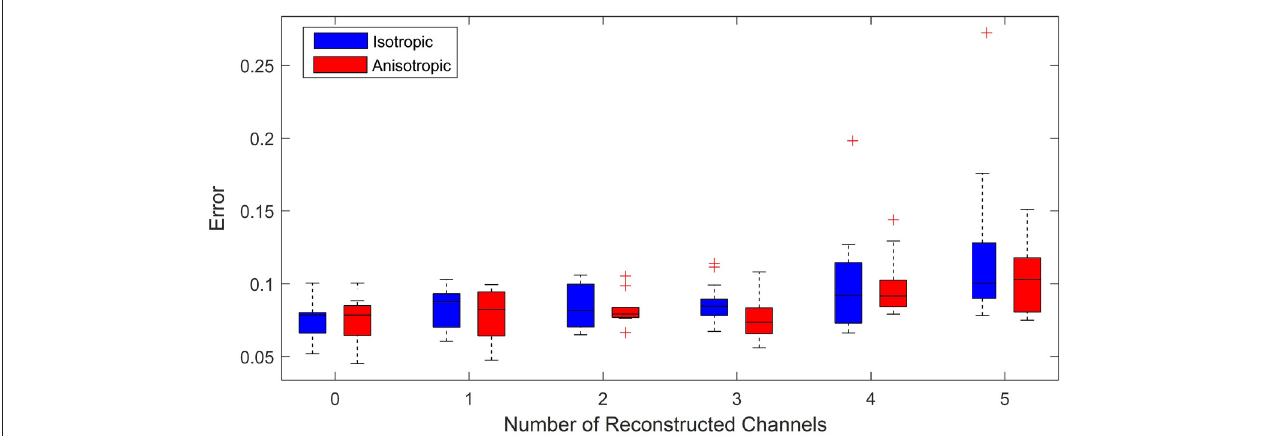
FIGURE 6 | Error vs. number of reconstructed channels. Box plot illustrating how increasing the number of missing channels influences the minimized root mean squared error between the relative activation time curves obtained from the model (assuming both anisotropic diffusion (red) and isotropic diffusion (blue)) and the original clinical recording. For each case 20 simulations for up to 20 random choices of channels to be reconstructed were performed. ( + ) symbols denote outliers in the 1 % tail of the error distributions. The case of 0 reconstructed channels enables a comparison of the limit of goodness of fit between models and the clinical data. We see that for 3 or fewer channels being reconstructed, uncertainty is predominantly due to model choice rather than the number of reconstructed channels, as we see no significant change in the mean error between model and clinical data. We use an unequal variances t -test to determine whether the errors came from a distribution with equal mean and find that with the exception of 3 channels reconstructed there is no significant difference in the errors between